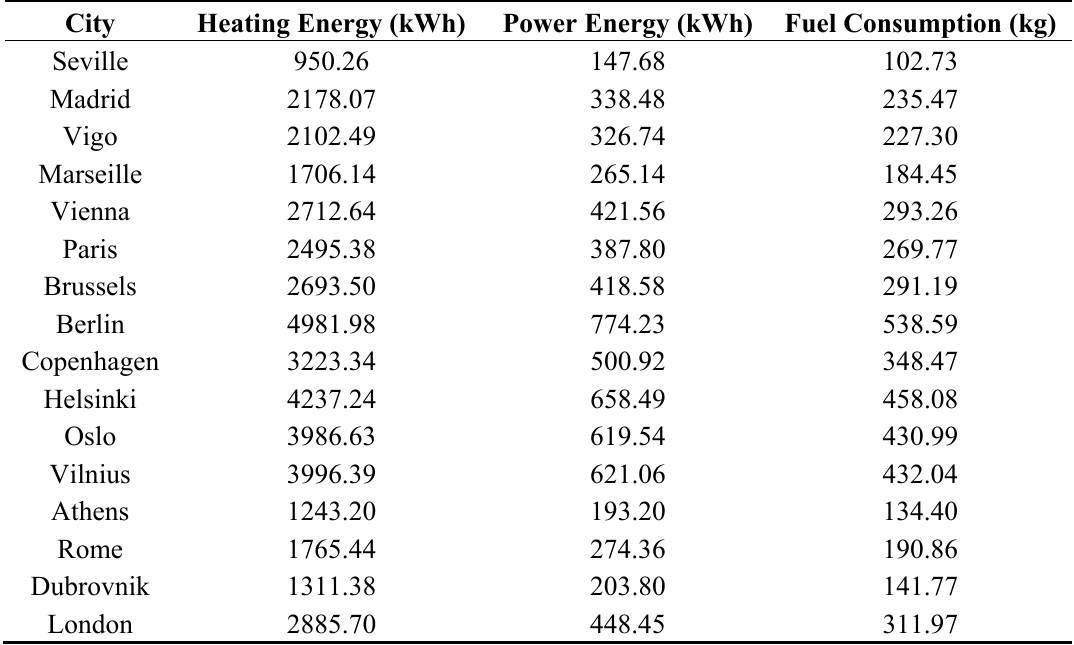
Table 6. Heat and electricity production and fuel consumption for all of the study